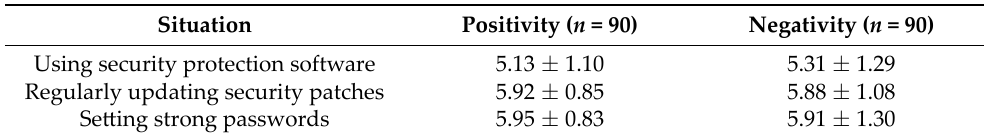
Table 11. Comparison of Means for Situation and Framework Properties (Mean ± Standard Devia‑ tion).